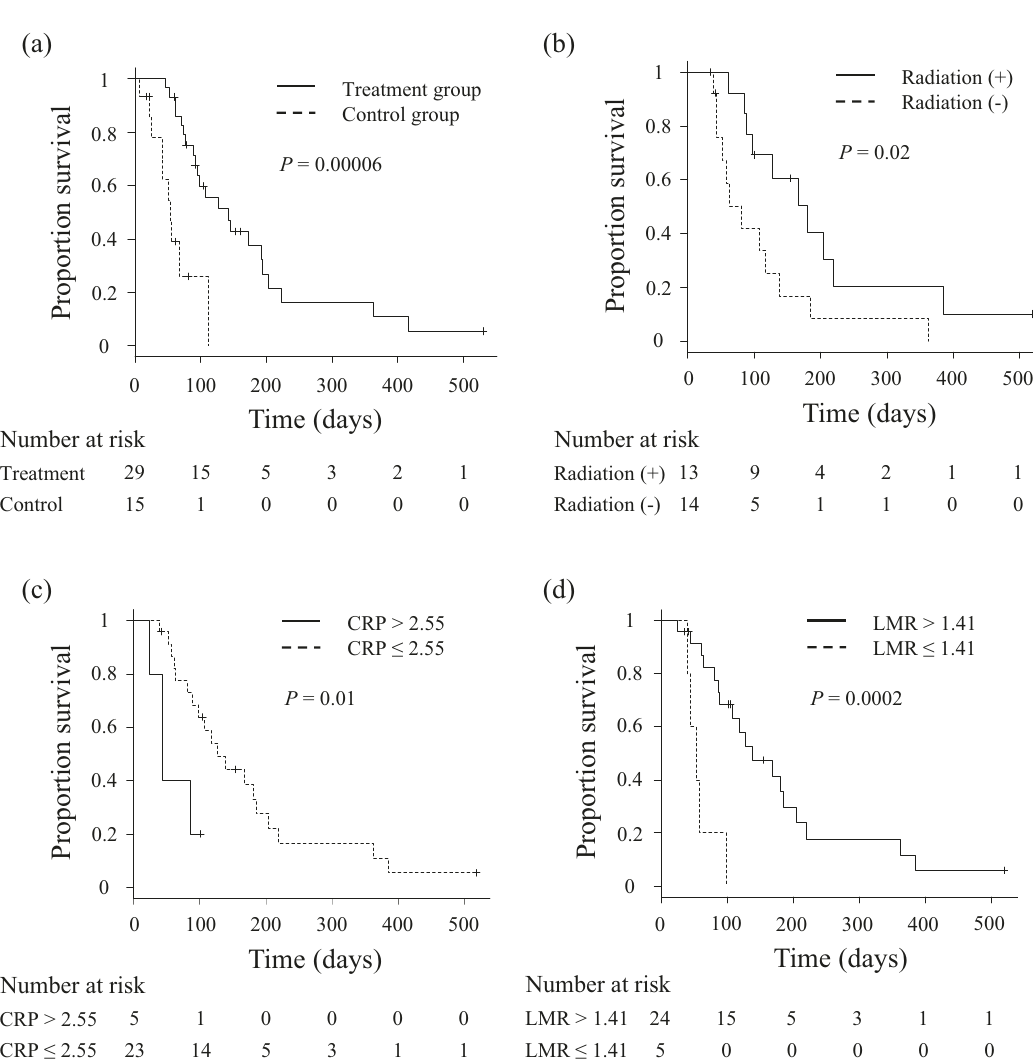
Fig. 3 Survival of dogs treated with c4G12. a Comparison of survival between c4G12 treatment group ( n = 29) and historical control group ( n = 15). Survival (days) was de fi ned as time from con fi rmation of pulmonary metastasis to death. For subgroup analysis, the treatment group was dichotomized according to ( b ) the use of previous/concomitant radiation, ( c ) plasma C reactive protein (CRP) levels (cutoff 2.55 mg/dL), or ( d ) the lymphocyte-to-monocyte ratio (LMR, cutoff 1.41), and overall survival was compared between the subgroups. Dogs that received radiation therapy concomitantly or ≤ 8 weeks before the initiation of antibody treatment were classi fi ed into radiation ( + ) subgroup. Marks on the line indicate censored data. Statistical analysis was performed using the log-rank